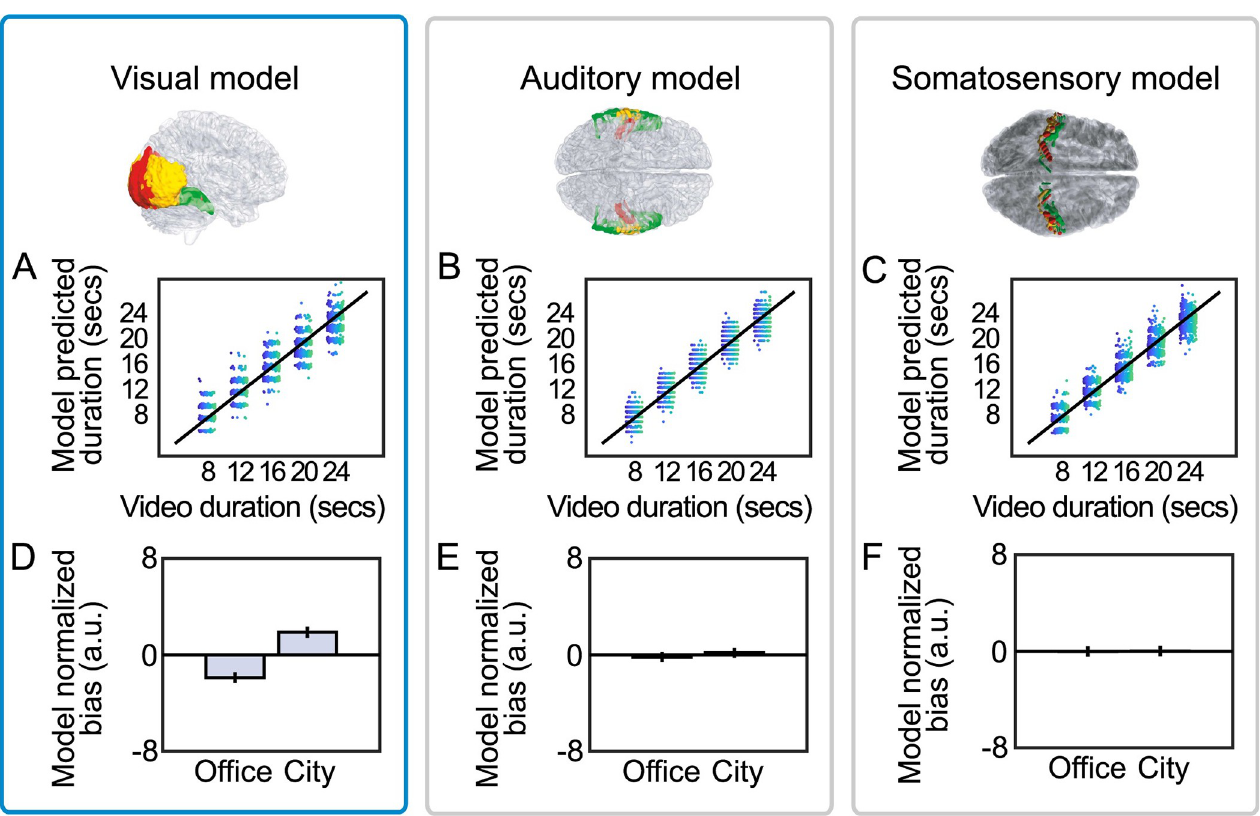
Fig 6. Computational neuroimaging analysis. (A-C) Trial-by-trial association between presented video duration and model-predicted duration reports obtained from the visual, auditory, and somatosensory models. Different dot colors represent different participants, and each dot is data from one trial. (D-F) Mean model-estimated normalized bias as a function of video type for the visual, auditory, and somatosensory models. Error bars represent +/- within-subject SEM.